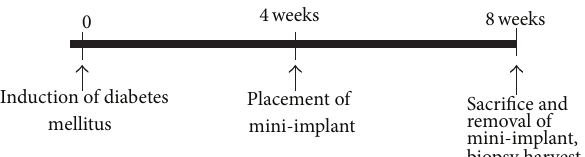
Figure 2: Chronologic sequence of the study.